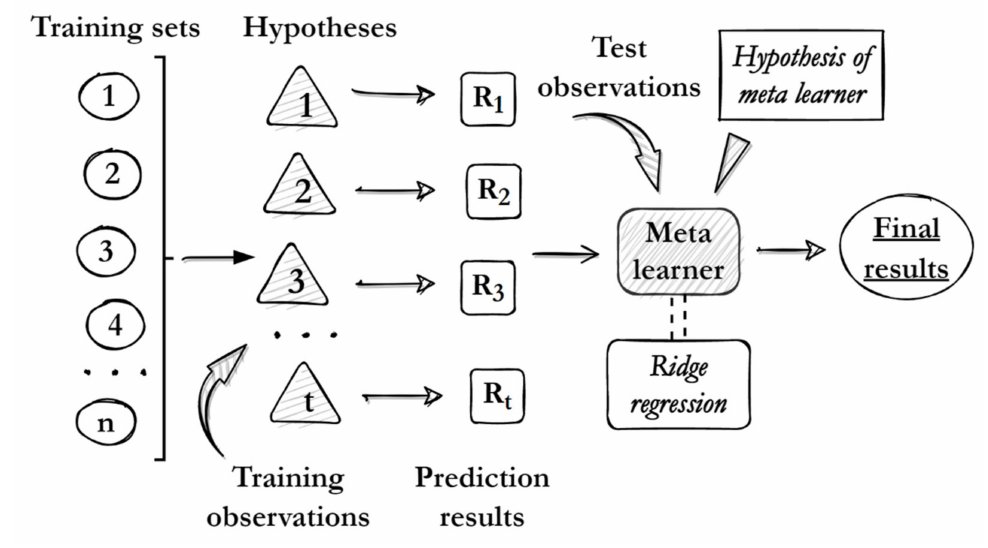
Figure 7. Schematic diagram of SG.